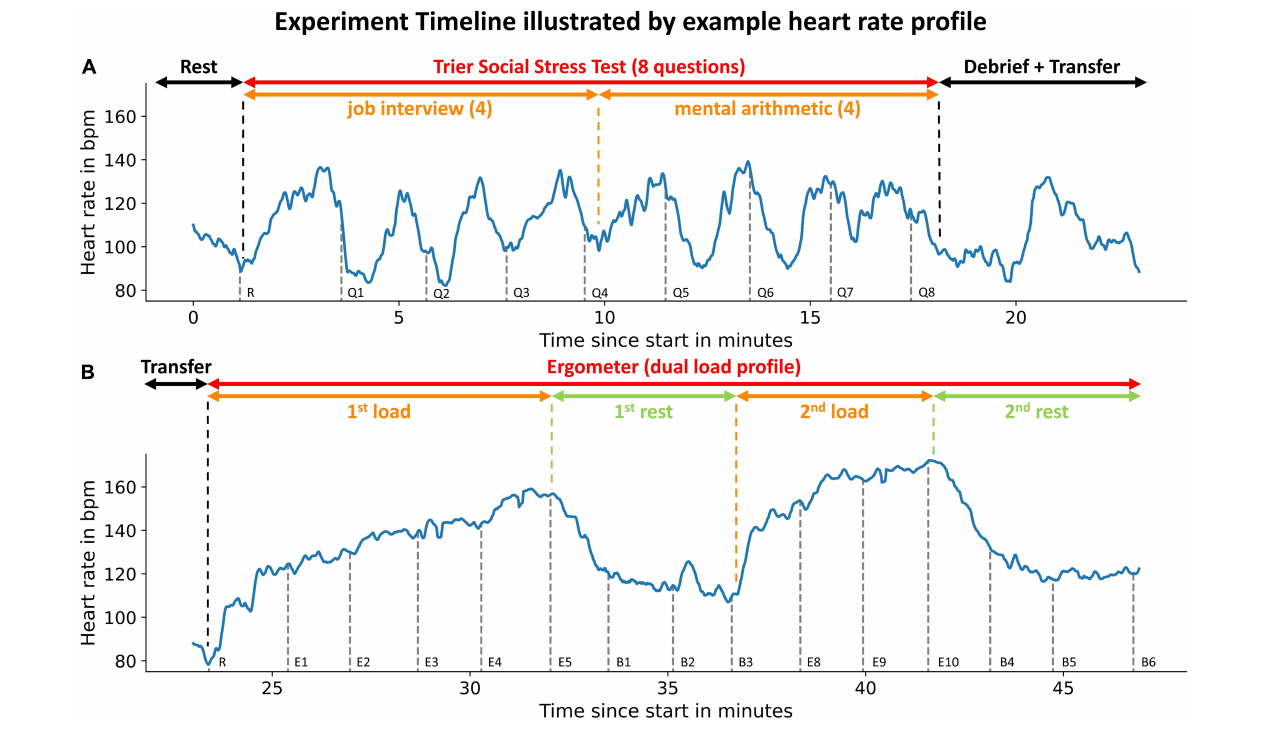
FIGURE2 Experiment timeline illustrated by example heart rate profile: Phases of the experiments are indicated by the uppermost arrows. Subsets of experimental phases are indicated by the second row of arrows. An example heart rate profile is displayed in blue. Gray dashed vertical lines indicate the initiation of blood pressure measurements. The measurement instance is denoted to the right of the dashed line. The participant did not reach load-phases E6 + E7 (see Figure 4 ). The upper panel (A) illustrates the first experimental phase (mental load), the lower panel (B) the second phase (physical